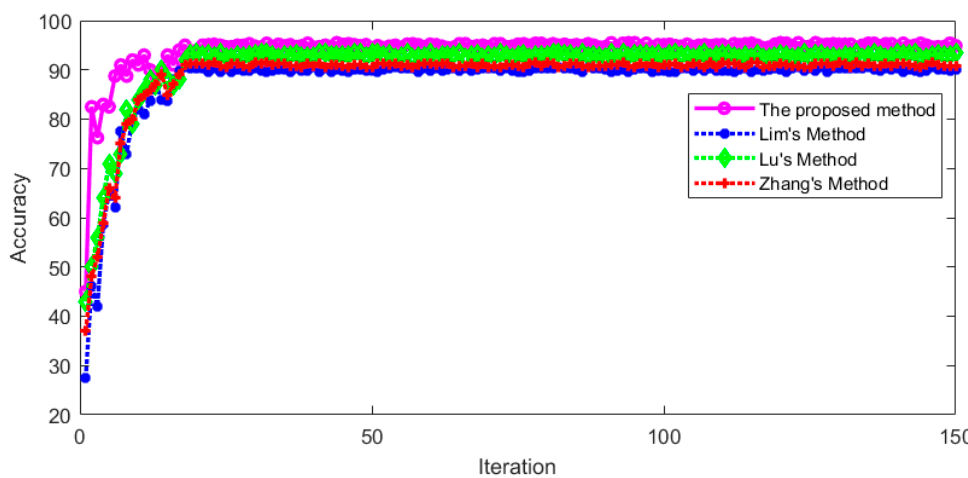
Figure 20. The recognition accuracy for four methods in training set.